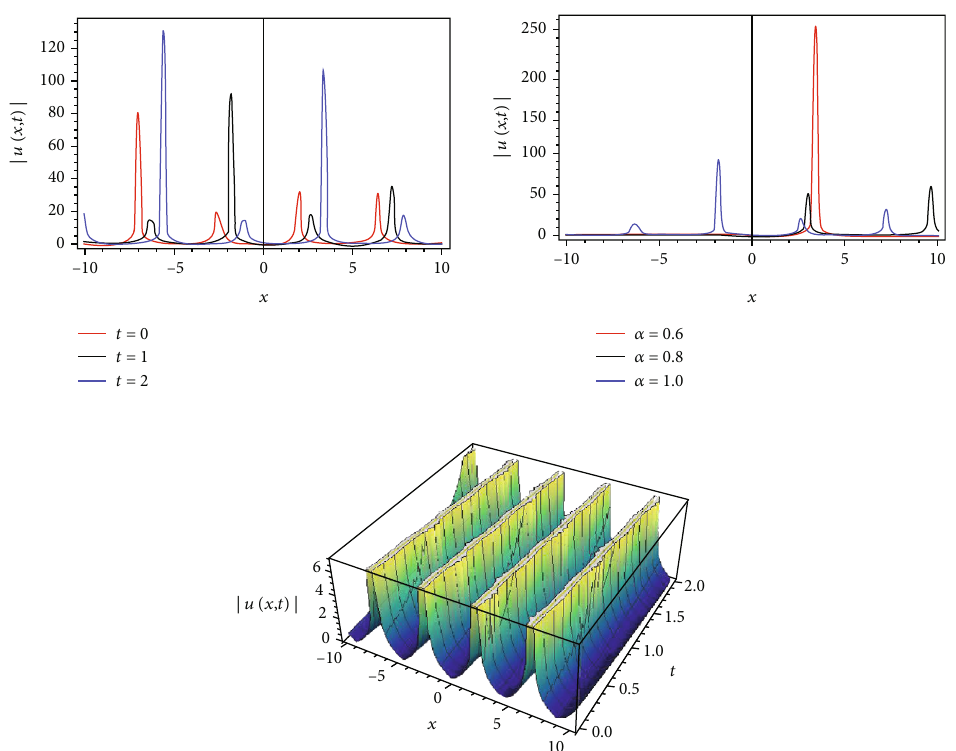
Figure 3: 2D and 3D graphics of Case 2 for trigonometric traveling wave solution (30) at f α = 0 : 6, k = 0 : 7, q = 1, s = 1, C = 1, c = 0 : 5 g :